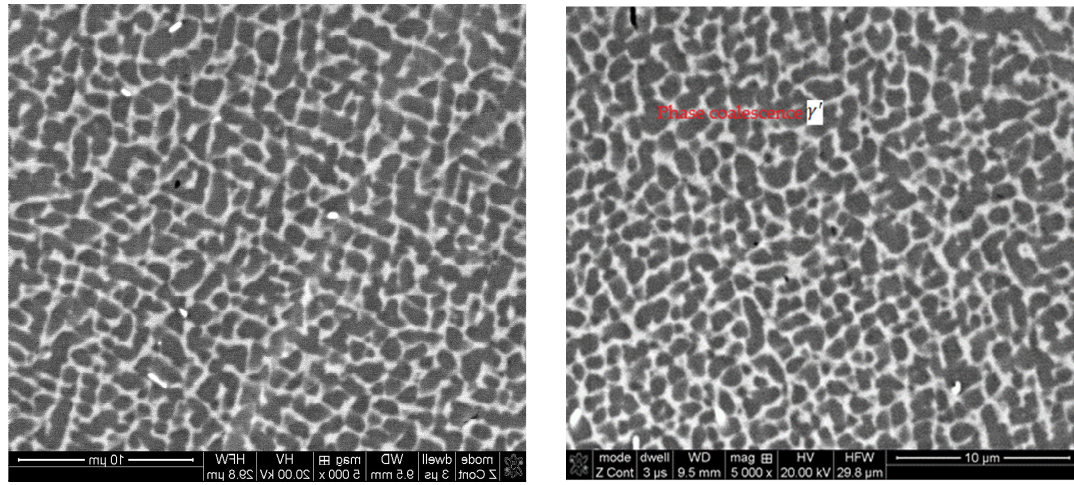
Figure 17. The microstructure of the γ / γ ’ phases in the parent material on the leading edge of the blade covered with an APS + VPA type protective coating.